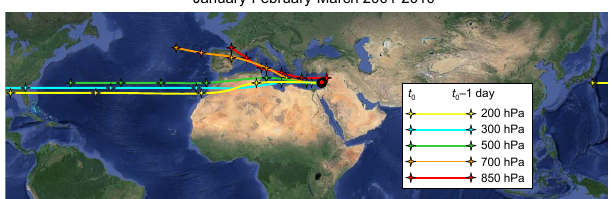
Figure 8. Top: climatological six-day back trajectories from the point at 33 ◦ N, 35 ◦ E located in the EMB (red filled circle) cal- culated from the British Atmospheric Data Centre trajectory ser- vice (http://badc.nerc.ac.uk/community/trajectory/) from 1 July to 31 August from 2001 to 2010 every 12h at 850 (red line), 700 (or- ange line), 500 (green line), 300 (blue line) and 200hPa (yellow line). The position of the gravity centre of each distribution at each level is represented every 24h by a star. Bottom: same as top, but calculated from 1 January to 31 March